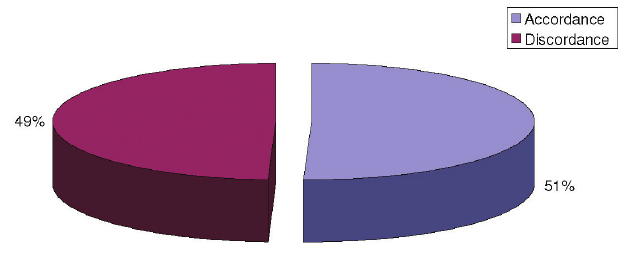
FIGURE 2 - Percentage of promotional pieces of rubber nipples, pacifiers, and nursing bottles in accordance or discordance with